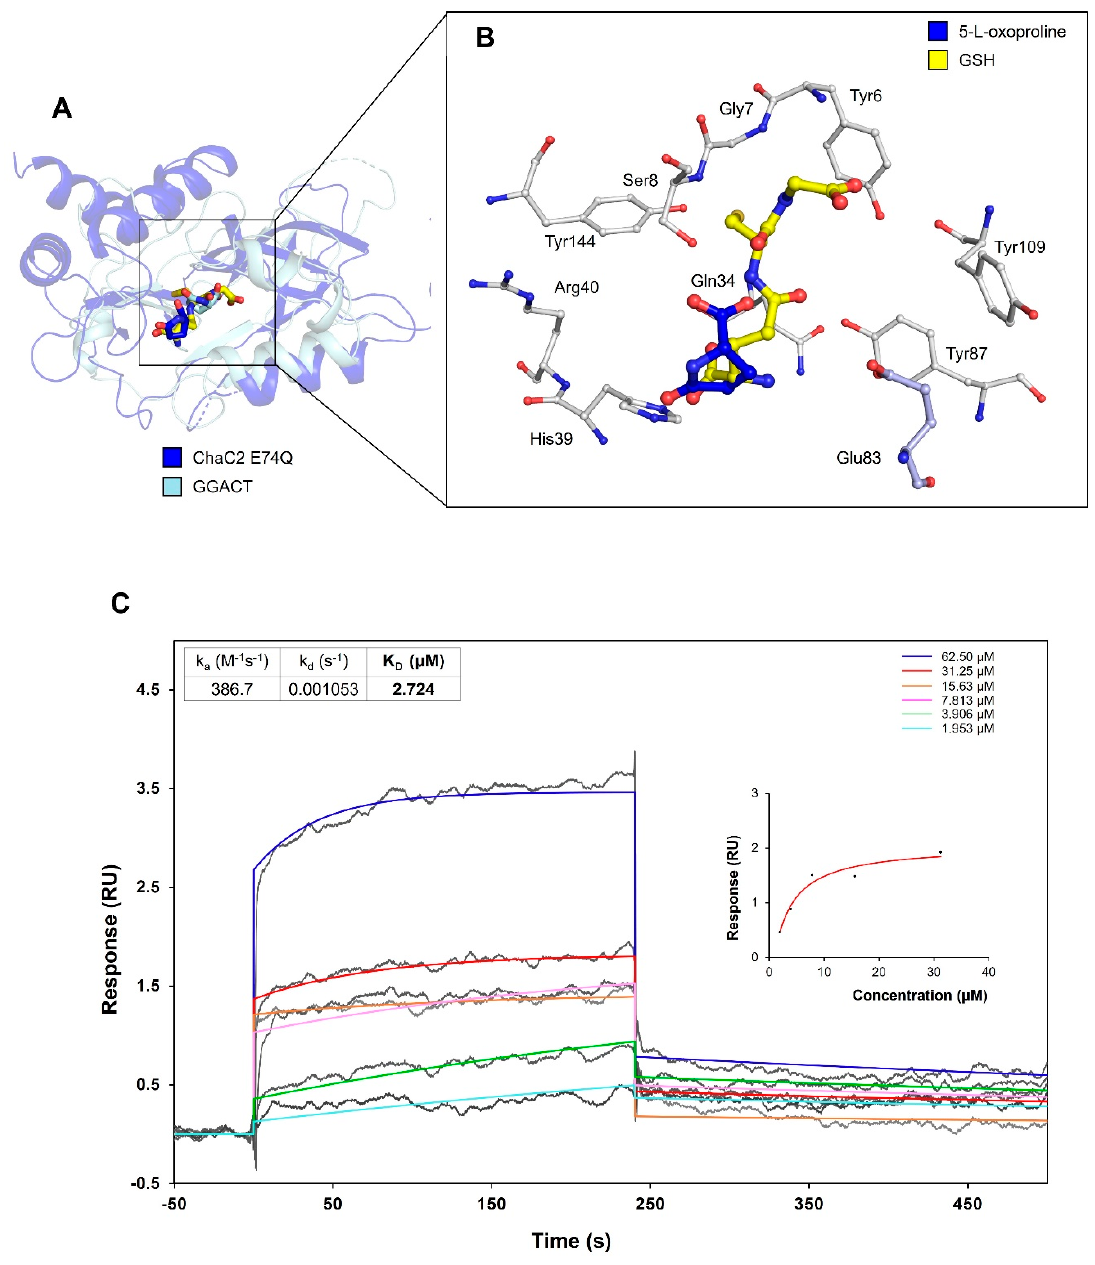
Figure 8. Docking model of ChaC2 E74Q with GSH and 5- l -oxoproline. ( A ) The docking models of GSH-ChaC2 E74Q and 5- l -oxoproline-ChaC2 E74Q have been superimposed onto the structure of GGACT in complex with 5- l -oxoproline. ChaC2 E74Q and GGACT are colored in blue and pale cyan, respectively. The GSH (docked into ChaC2 E74Q), 5- l -oxoproline (docked into ChaC2 E74Q), and 5- l -oxoproline (bound to GGACT) are denoted as yellow, blue, and pale cyan stick models, respectively. The docking binding energies of GSH and 5- l -oxoproline with ChaC2 are − 6.3 kcal / mol and − 5.2 kcal / mol, respectively. ( B ) Close-up view of the active site cavity of ChaC2. The ChaC2 E74Q residues recognizing GSH / 5- l -oxoproline and catalytic Glu83 are shown as stick models with white and light blue colors, respectively. ( C ) SPR experiments with ChaC2 E74Q E83Q and GSH. Various concentrations of free GSH were applied to immobilized ChaC2. Sensorgrams for 1.953, 3.906, 7.813, 15.63, 31.25, and 62.50 µ M GSH are shown in di ff erent colors. The K D value of GSH to ChaC2 E74Q E83Q was calculated as 2.724 µ